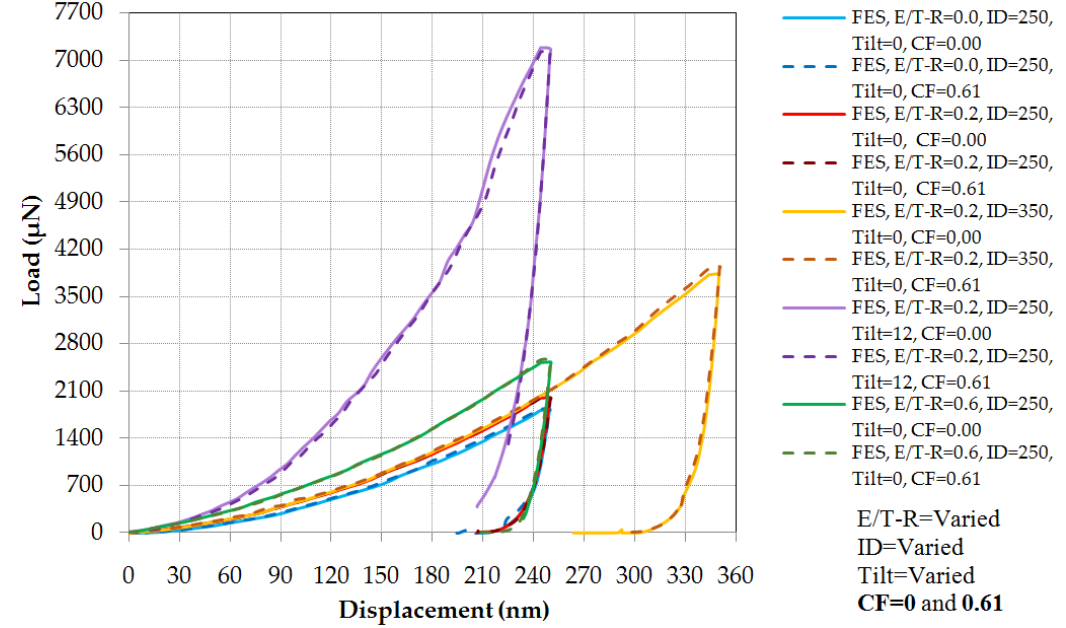
Figure 14. Critical load/unload-displacement curves of aluminum 1100 in the nanoindentation experiment based on different coefficients of friction between the indenter and the sample.